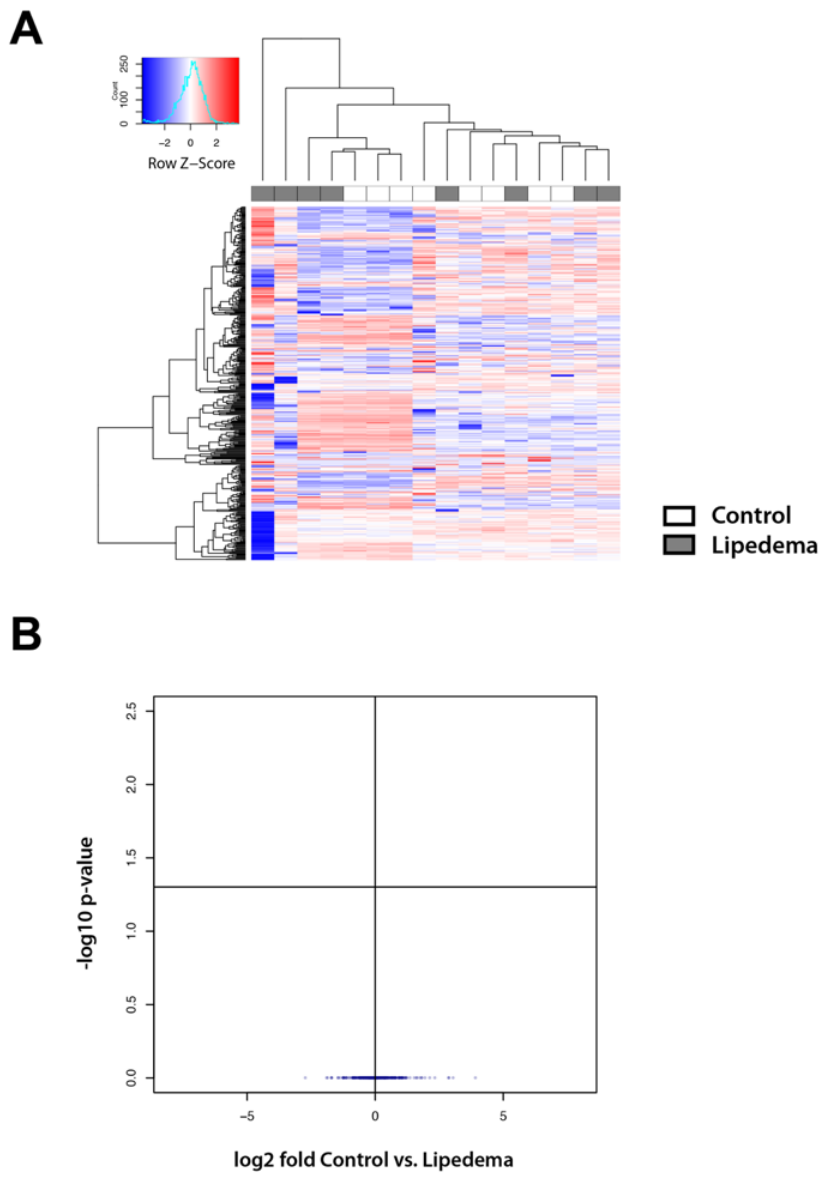
Figure 3. Lipid mass spectrometry analysis reveals a comparable lipid composition in the serum of lipedema versus control patients ( A ) Lipidomic heat map showing log2 fold change of molecular lipid species comparing serum of lipedema versus control patients using unsupervised hierarchical clustering. Each horizontal row represents a molecular lipid and each vertical column represents a serum sample. Relative change of each lipid is indicated by coloring, and the scale is represented in the color key. ( B ) Volcano plot showing no statistically significant alterations in the lipid composition between the disease and the control groups. N (Control): 8 patients and N (Lipedema): 8 patients.